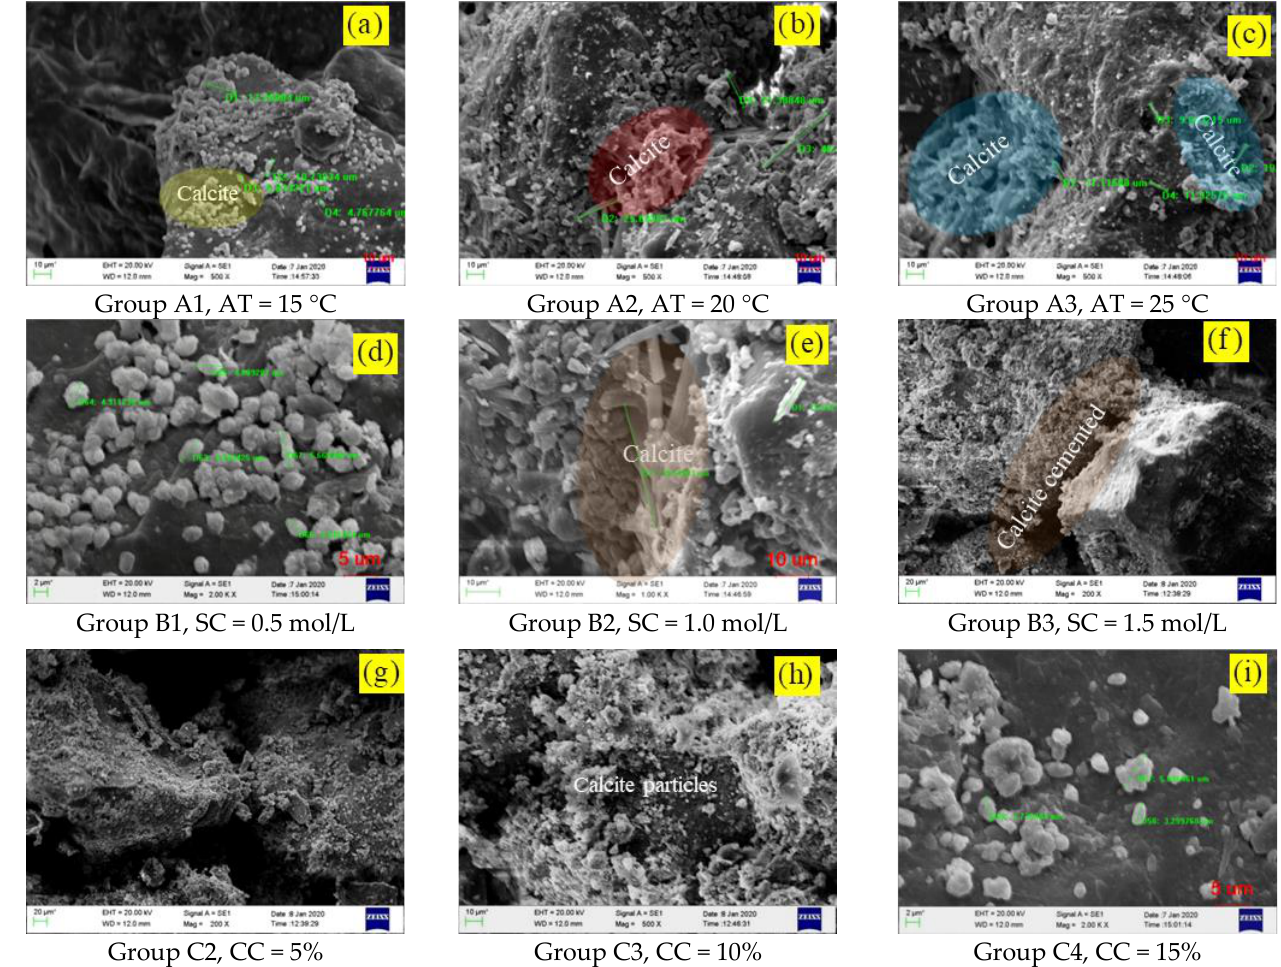
Figure 11. The presence of CaCO 3 under different conditions.